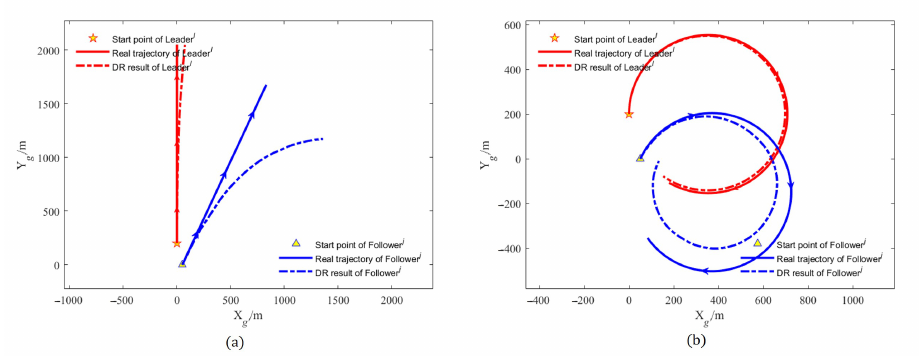
Figure 3. Trajectory diagram of Leader l and Follower j in a test. ( a ) AUVs moved along a straight line at a uniform constant speed; ( b ) AUVs moved along a curve at a uniform constant speed.